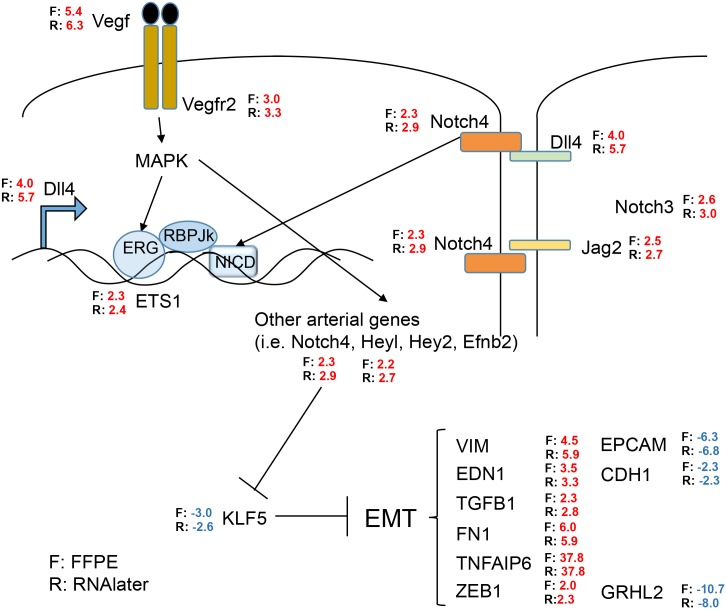
Pathway signature of VEGF and NOTCH mediated EMT in ccRCC.Comparison of gene expression data from the FFPE and from the RNAlater® dataset with published results [20] and between themselves. F = FFPE samples, R = RNAlater®
samples, Numbers = fold change of up-regulation (red) or down-regulation (blue).